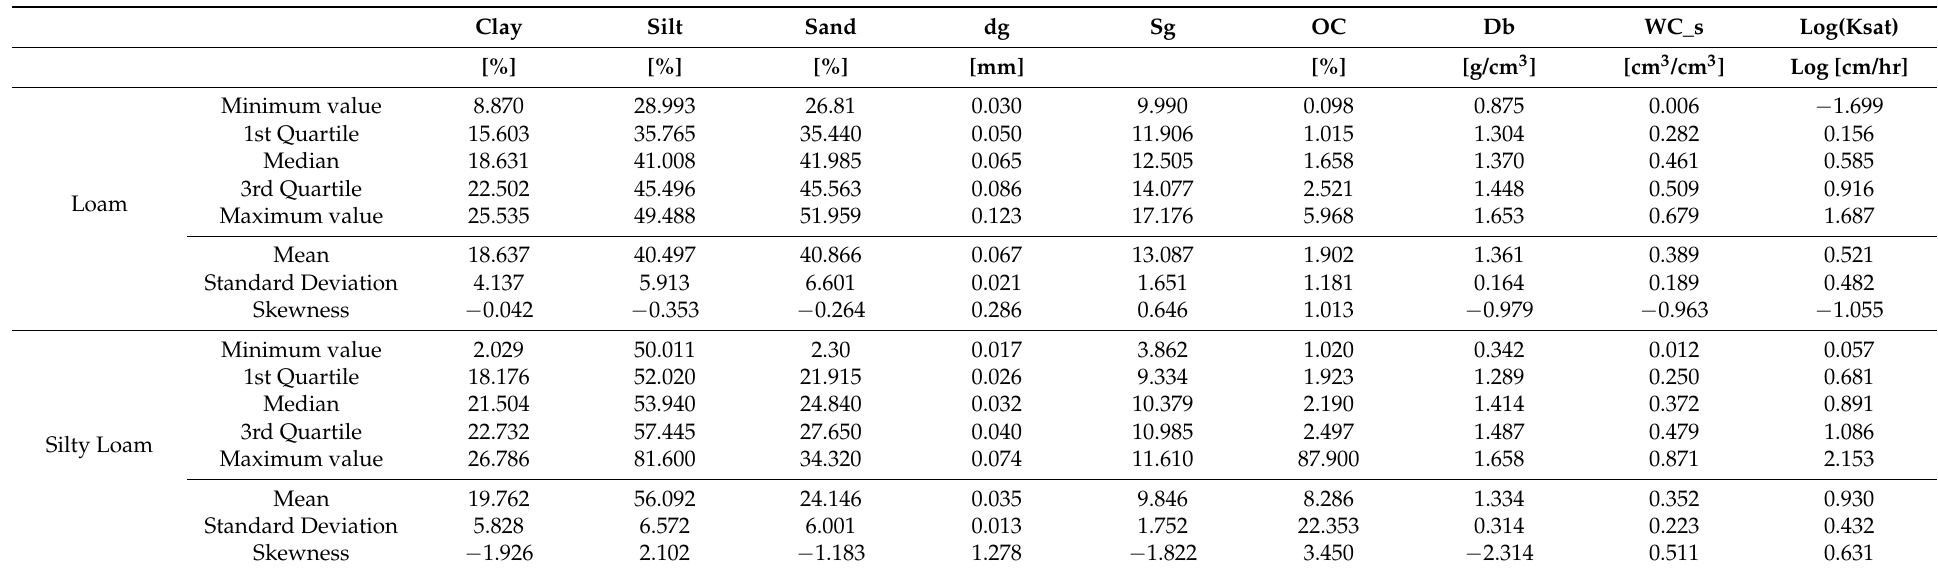
Table 2. Characteristics of the training dataset